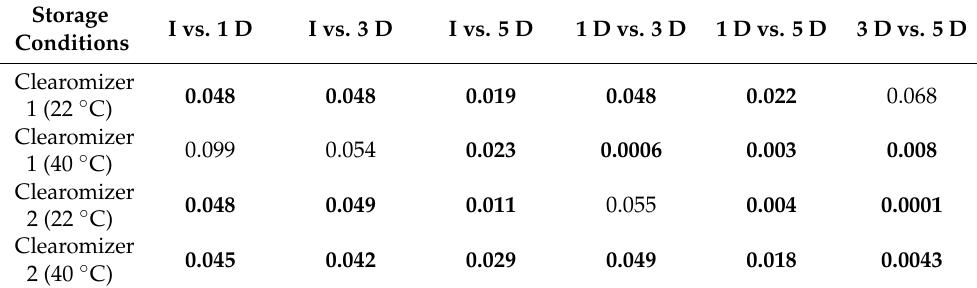
Table 5. The influence of the duration of storage on Pb concentration; p -value for the paired t -test ( t -test: Paired Two Sample for Means).